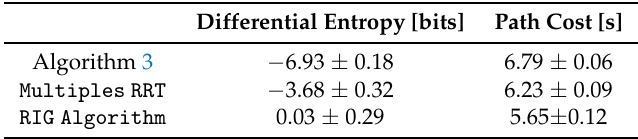
Table 2. Posterior differential entropy and path cost evaluated over the completeenvironment after measuring , calculated for 180 s of planning time. P x r , s ∗